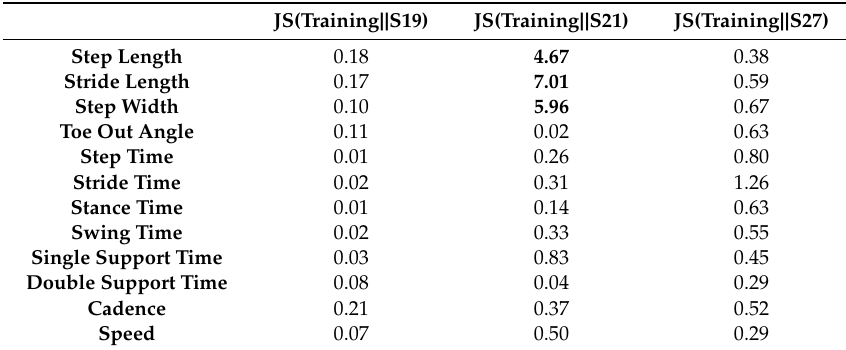
Table A1. Jensen–Shannon (JS) divergence (relative entropy) between test subjects and training on fold with subjects S19, S21, and S27.